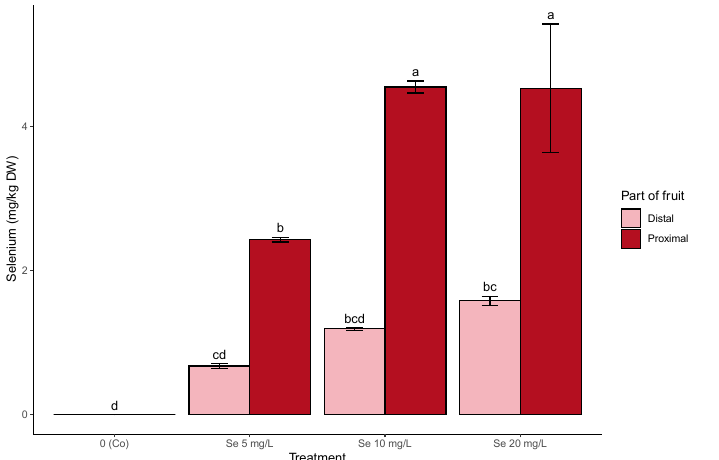
Figure 4. Content of Se in tomato fruit treated under a vacuum at 0, 5, 10, and 20 mg Se L − 1 in the form of sodium selenate. Values are the means ± SE ( n = 3). Values with the same letter are not statistically different ( p ≤ 0.05).